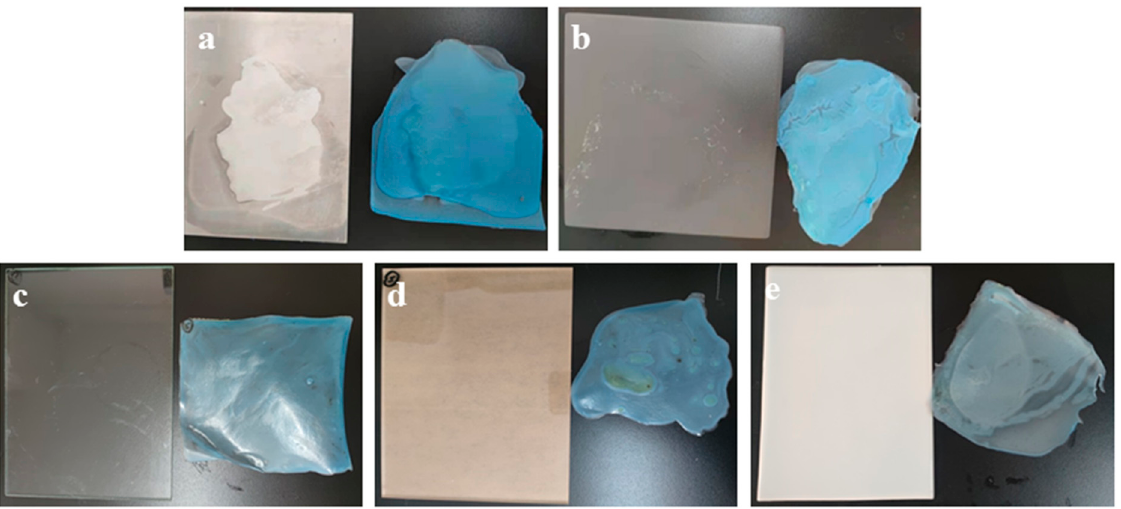
Figure 9. Photographs of decontamination of different surfaces: ( a ) lacquered surface, ( b ) aluminium surface, ( c ) glass surface, ( d ) plastic surface, ( e ) ceramic surface.